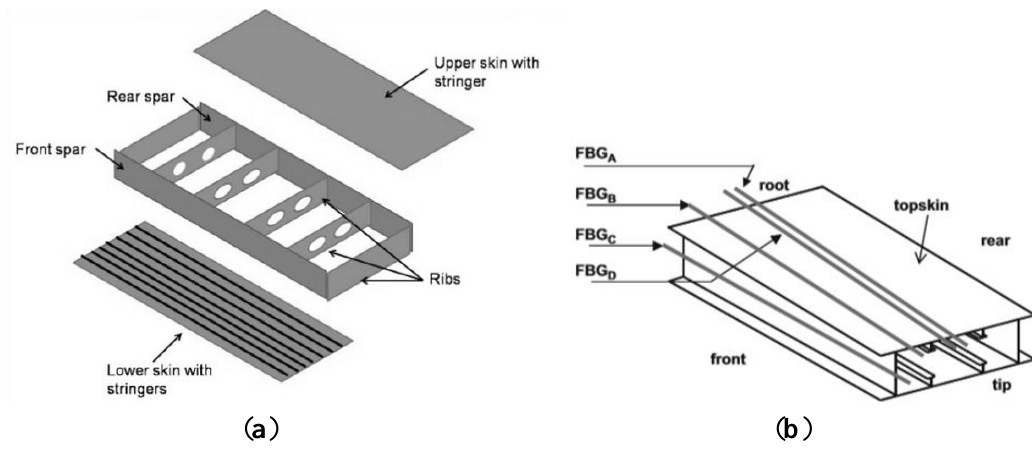
Figure 11. Typical scheme of wing box ( a ); deployment of the optical fibres in the structure ( b